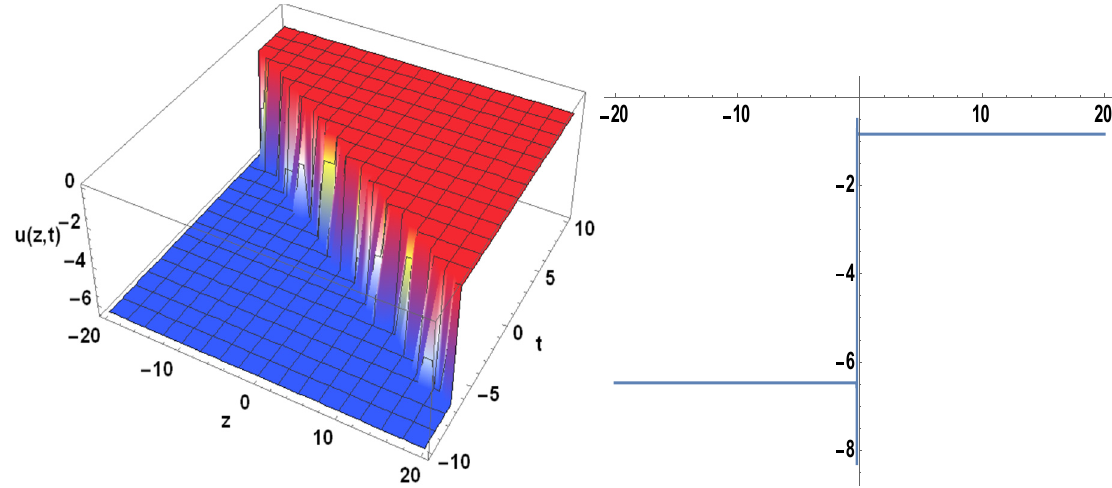
Figure 5. The 3D and 2D plots of Equation (55) for various values of parameters.